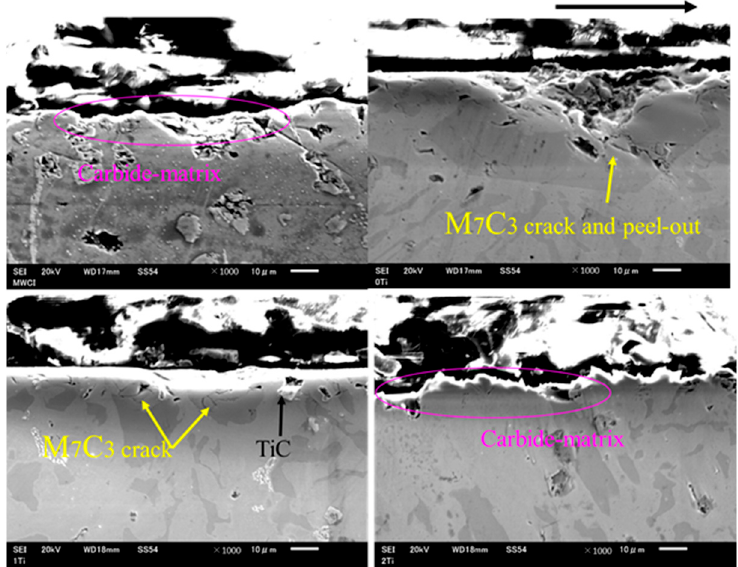
Figure 13. The cross-section of each material after being tested with big silica sand particles with highly magnified SEM.